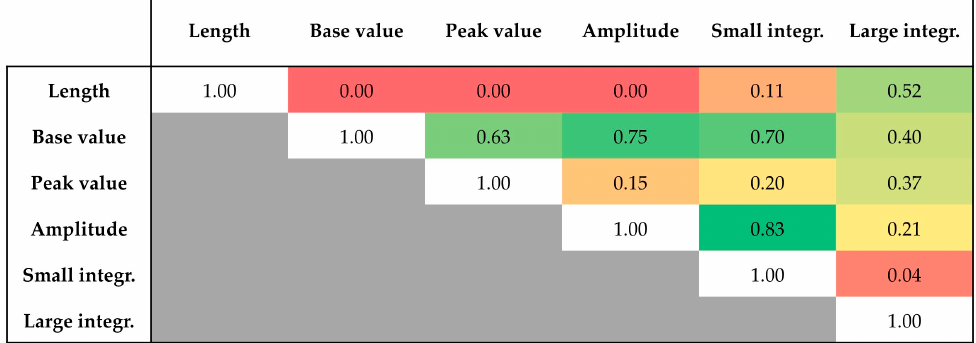
Figure 12. Matrix of the seasonal parameters in terms of R 2 .